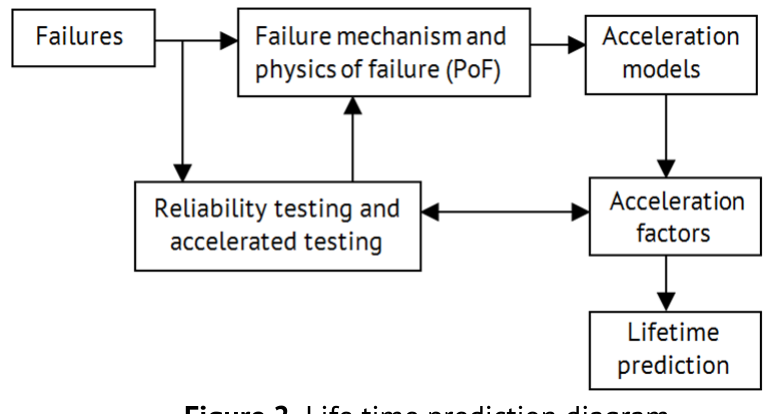
Figure 2. Life time prediction